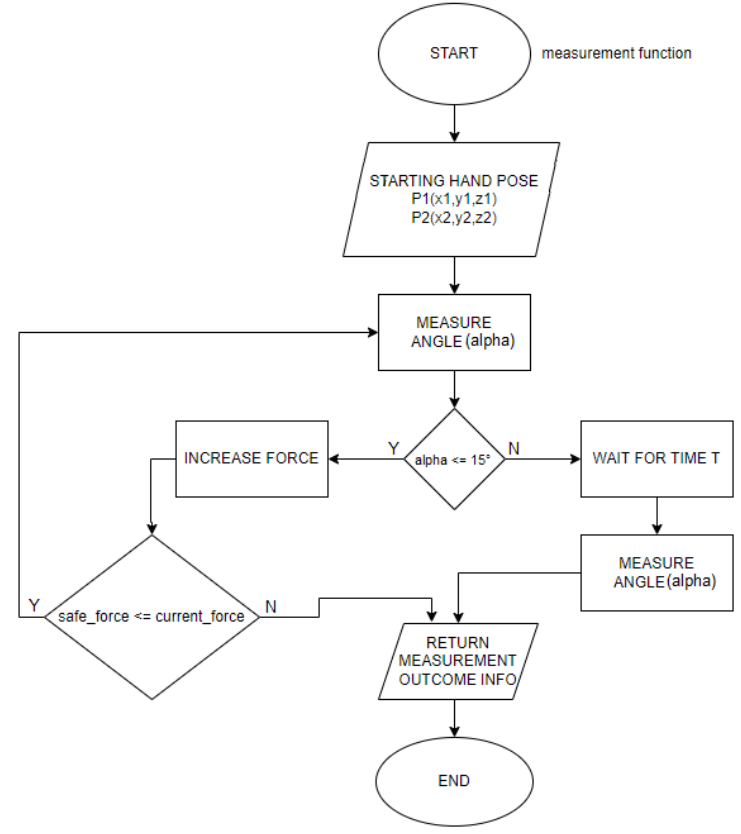
Figure 4. Visualization of user interface showing measurement